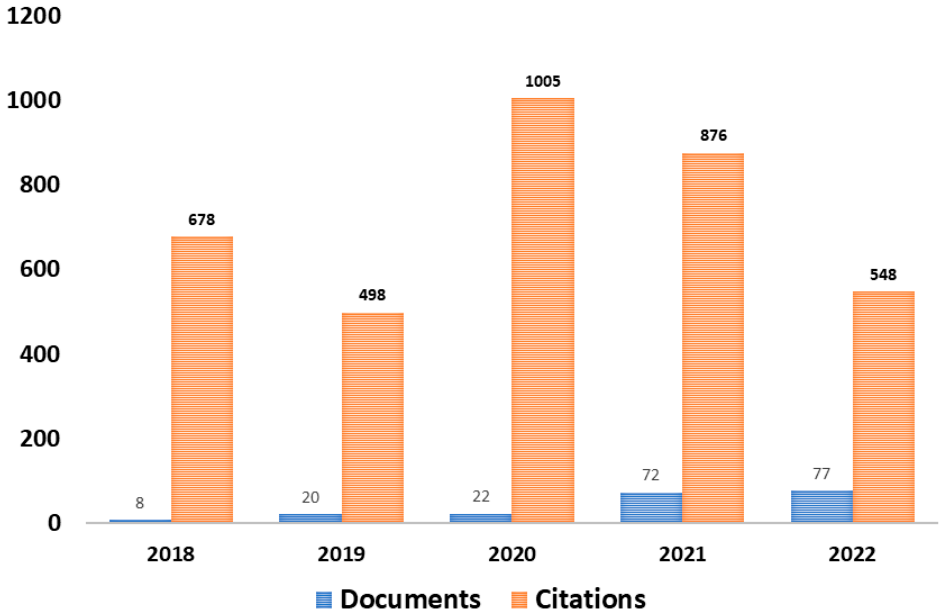
Figure 2. Number of documents and citations in the databases using the search terms and filter between 2018 and 2022. Source: authors, 2022.